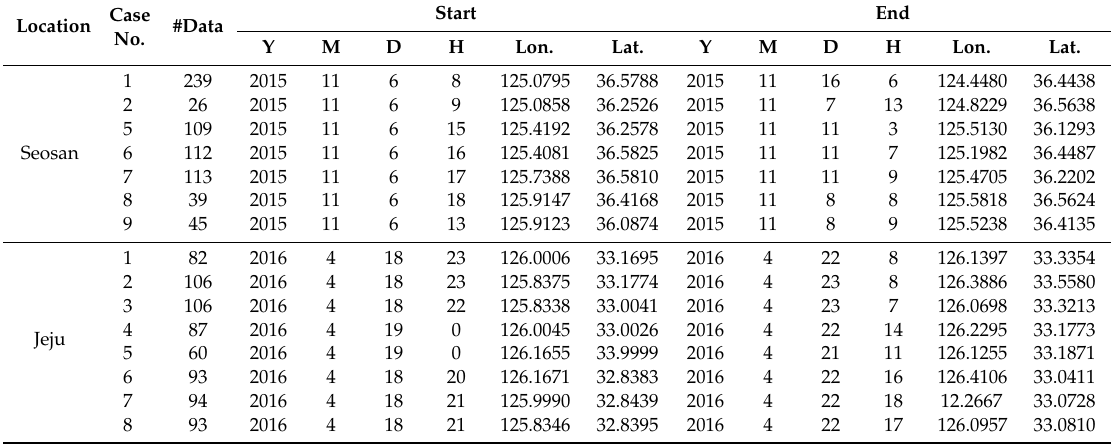
Figure 1. Observed trajectory data from Seosan and Jeju in 2015. Table 1. Attributes of the data